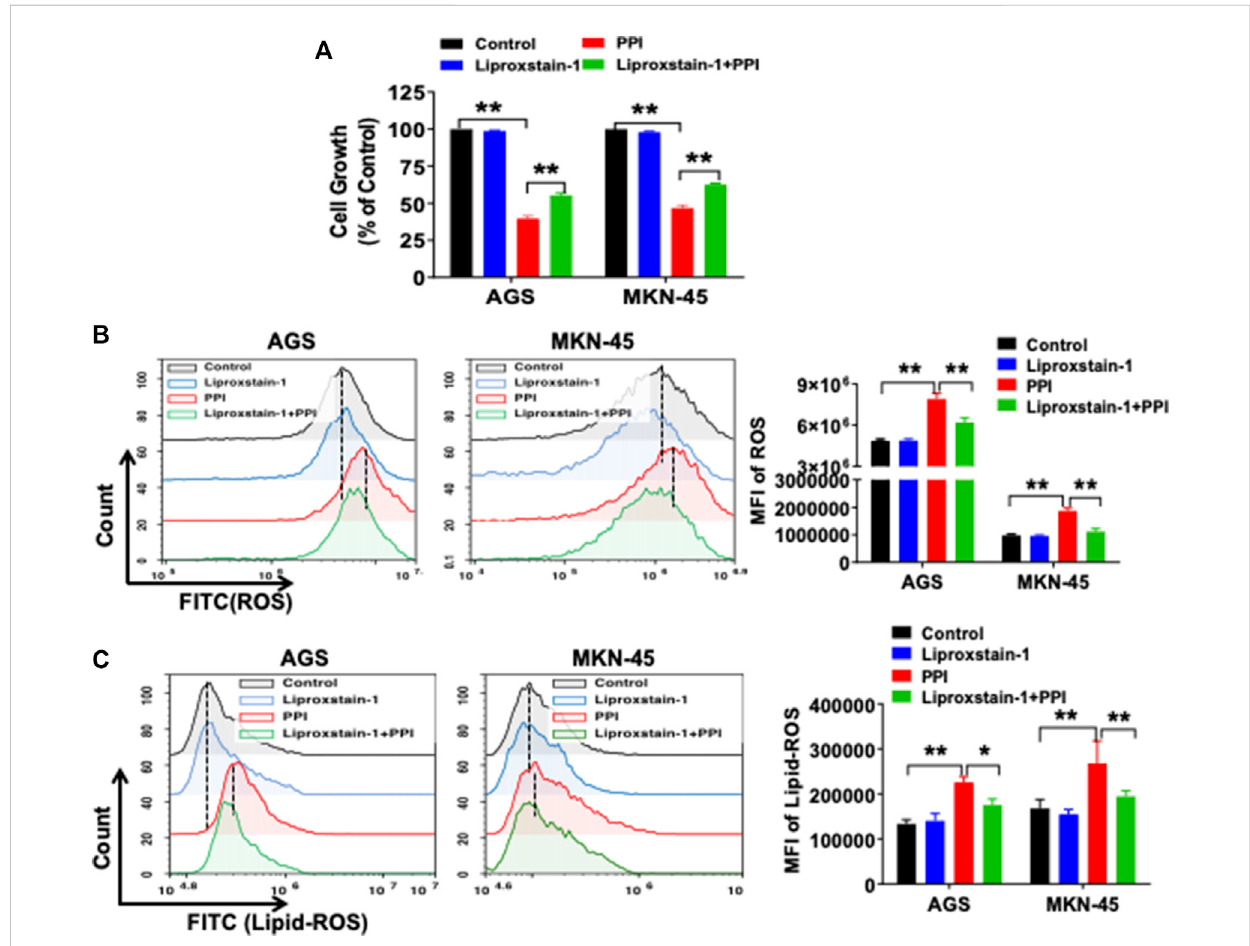
FIGURE 3 A ferroptosis inhibitor reverses PPI-induced ferroptosis and suppression of gastric cancer cell growth in vitro . (A) AGS and MKN-45 cells were pretreated with an inhibitor of ferroptosis, liproxstain-1 (200 nM), for 2 h, and then PPI was added for an additional 24 h. Cell growth/expansion was measured via MTT assays. (B and C) Intracellular ROS and lipid peroxides (lipid-ROS) levels were measured using fl ow cytometry. Data are shown as mean ± SD. p values were determined using one-way ANOVA (* p < 0.05, ** p <